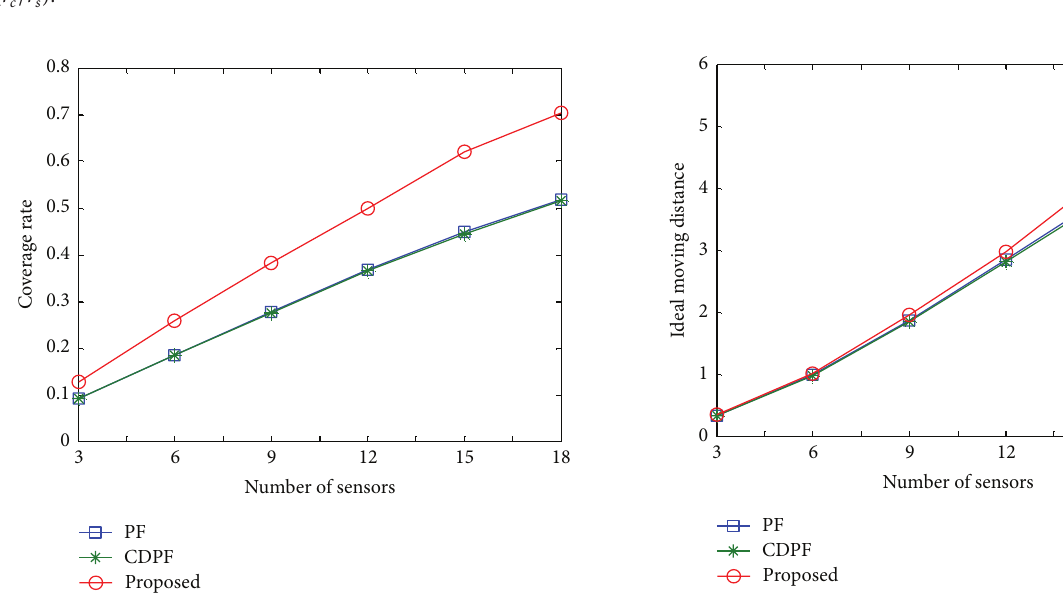
Figure 8: Coverage hole rate versus number of sensors.